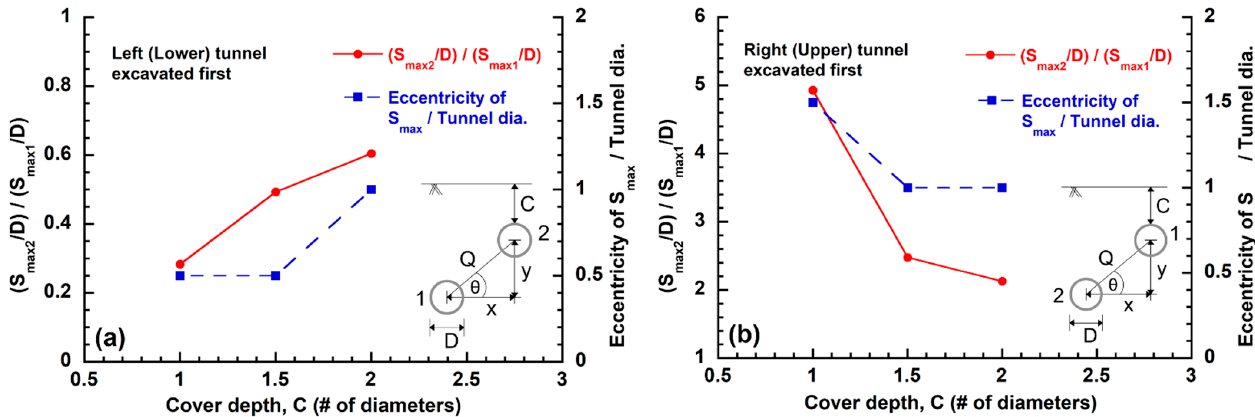
Figure 22. Design chart for preliminary estimation of the ratio of the maximum settlement of the excavated second tunnel to the greenfield tunnel and the eccentricity of the maximum total settlement relative to the center of the new tunnel. ( a ) Lower tunnel excavated first, ( b ) upper tunnel excavated first.